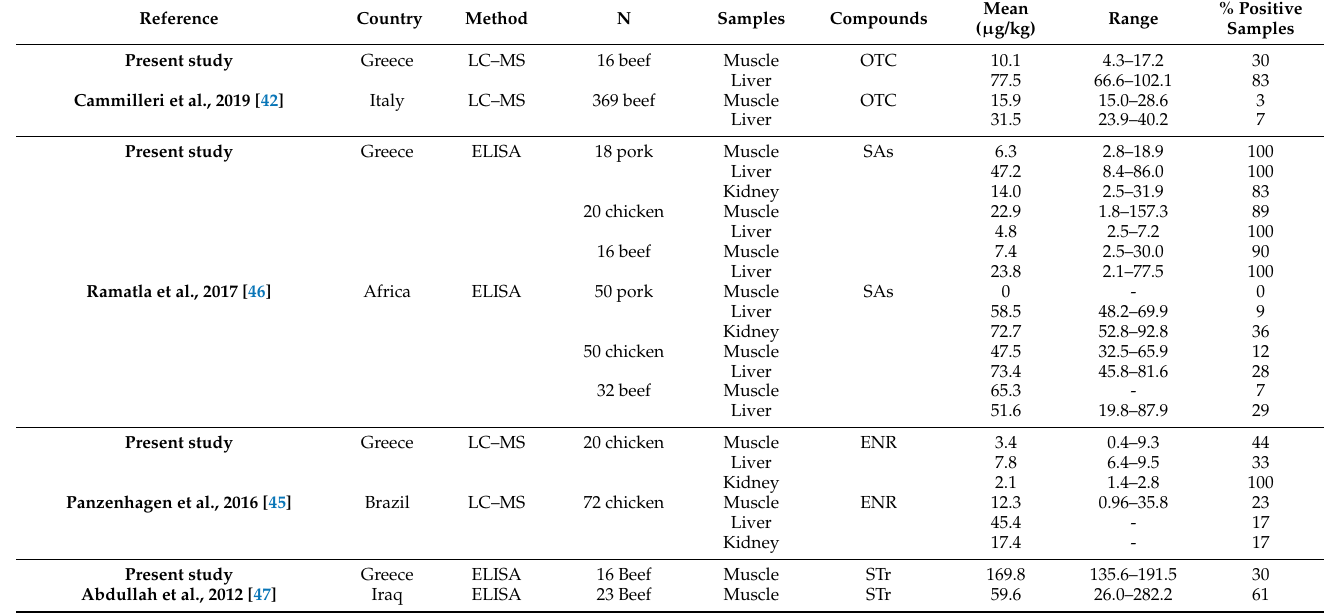
Table 9. Comparison between current results and data from other monitoring studies in